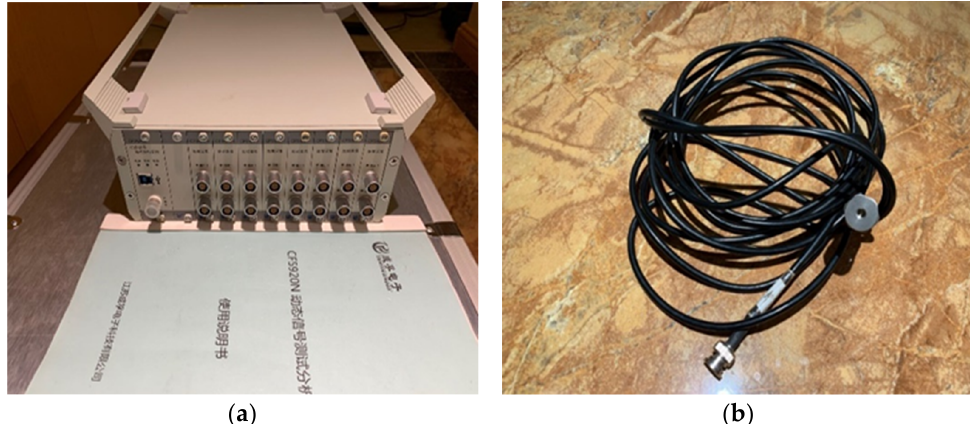
Figure 3. Monitoring instruments. ( a ) CF5920N dynamic signal test analyzer; ( b ) 173A500 Acceleration Sensor.